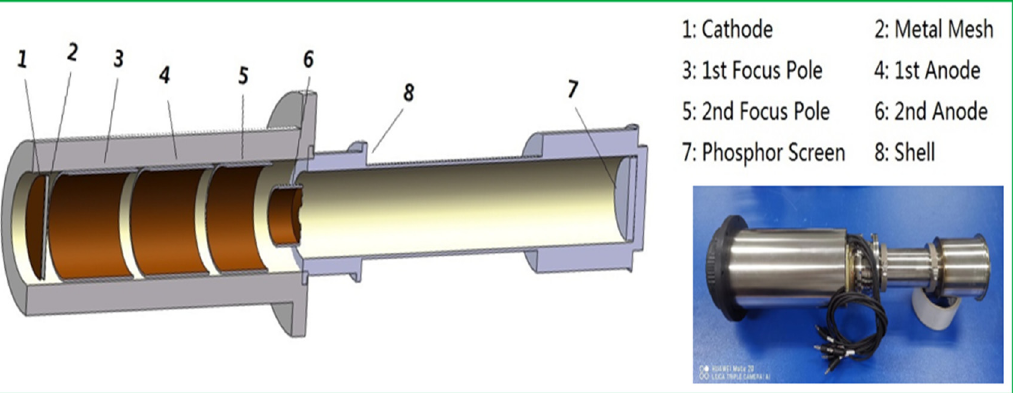
Figure 3. The structure and physical image of the streak tube used in the test: on the left is the in- ternal structure diagram of the streak tube and in the lower right corner is the physical image of the streak tube. Table 1. Parameters of streak tube.